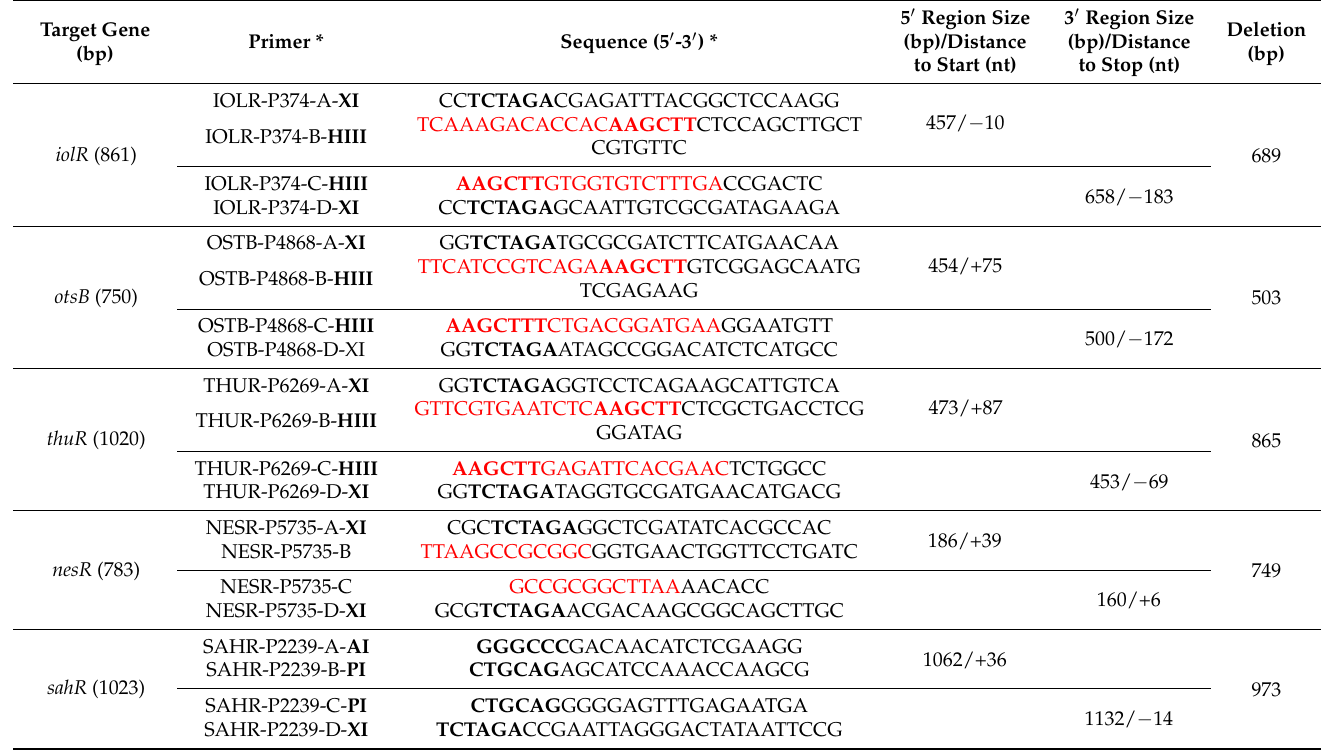
Table 2. Primers used in this